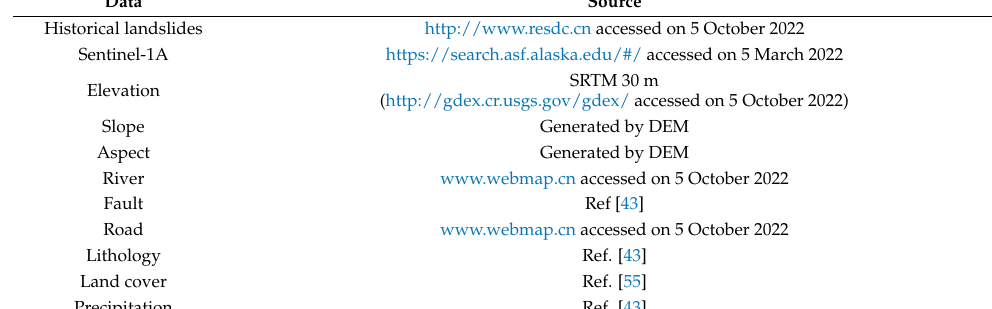
Table 4. Summary of data in this study.